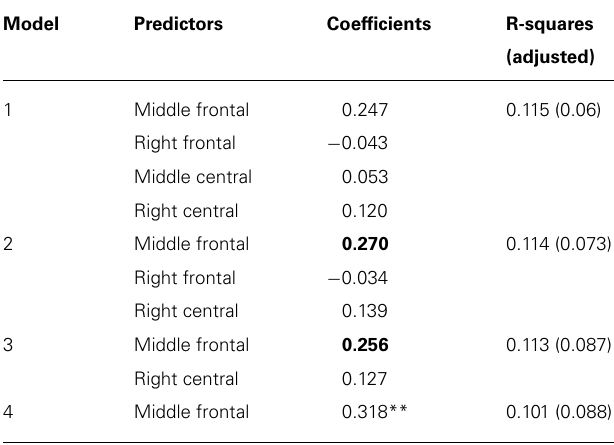
Table 4 | Standardized coefficients and R-squares for subsequent models in backward elimination regression with OSPAN as a dependent